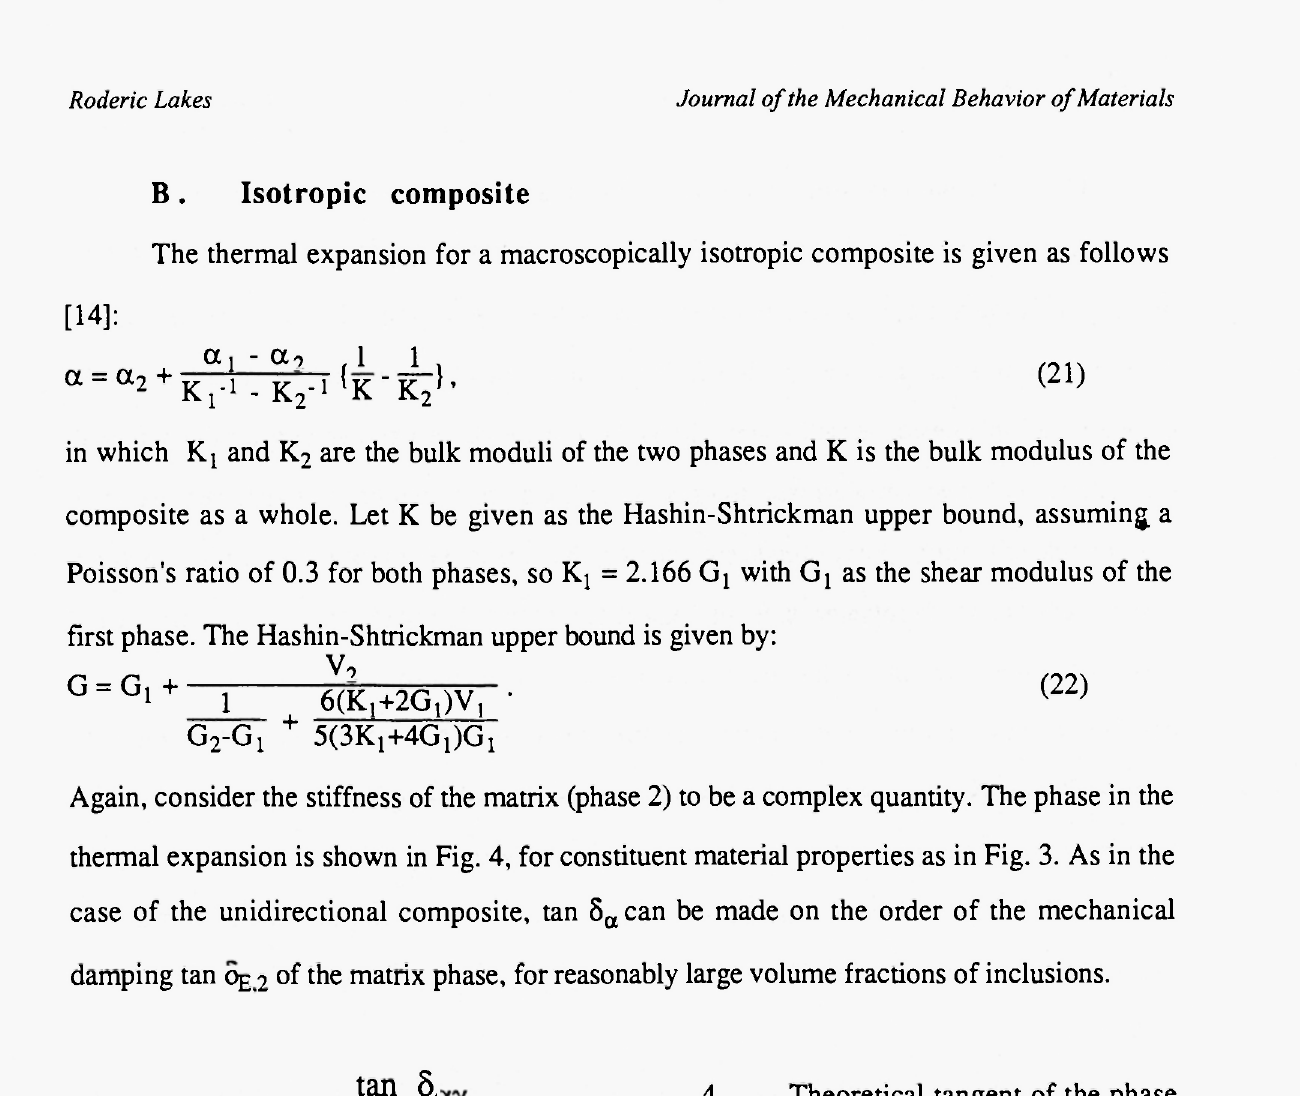
Theoretical tangent of the phase angle δ in the thermal expansion of an α isotropic composite in terms of the mechanical damping tan 5g of the matrix phase, and thermal expansion a